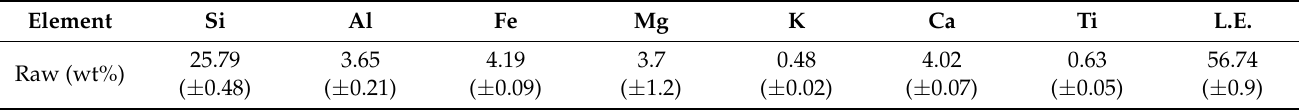
Table 1. Elemental analysis of the palygorskite